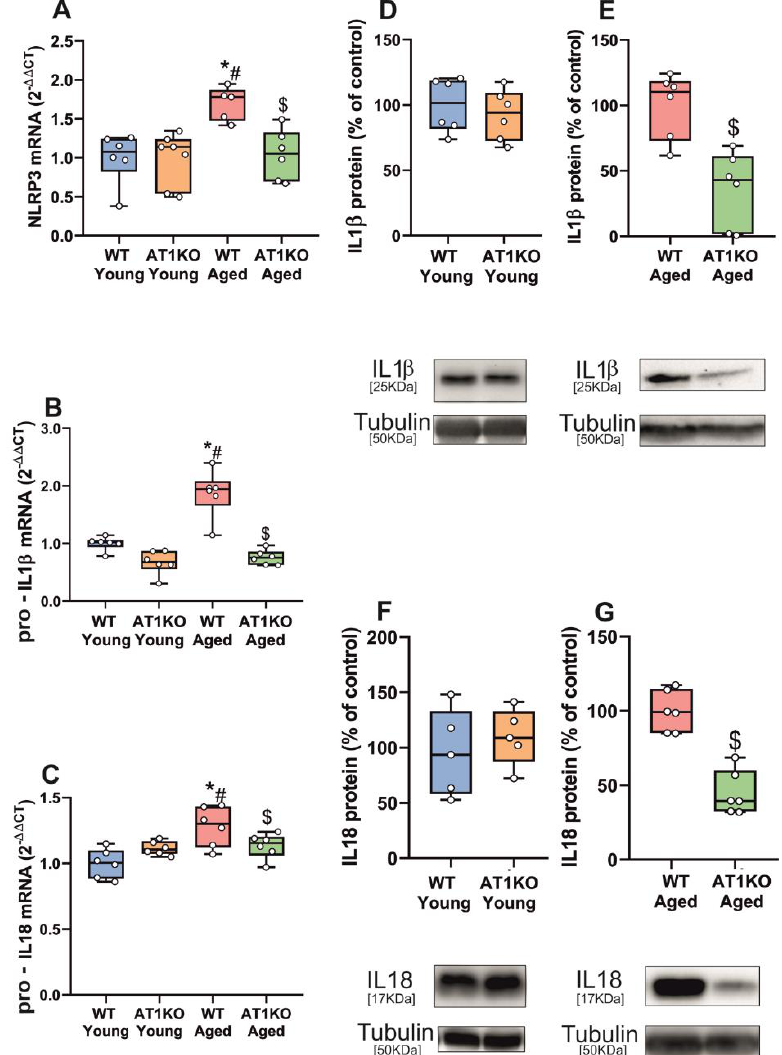
Figure 2. qRT-PCR and WB analysis of NLRP3 inflammasome markers in substantia nigra of WT and AT1 KO mice. mRNA expression of NLRP3, pro- IL1β and pro -IL18 inflammasome markers of aged WT mice significantly increased relative to young WT mice ( A – C ). mRNA inflammasome markers significantly decreased in aged AT1 KO mice vs. aged WT mice ( A – C ). Protein expression of IL1β and IL18 did not show differences in young AT1 KO mice vs. young WT mice ( D , F ) and significantly decreased in aged ATI KO mice vs. aged WT mice ( E , G ). To determine the relative mRNA expres- sion of each gene of interest vs. the β -Actin housekeeping transcripts, we used the comparative Ct values method (2 −ΔΔCt ). Protein expression was determined relative to the α -tubulin band value and normalized to the control values (100%). Data distribution is shown using box plots with boxes rep- resenting the Interquartile range (IQR) and the median and whiskers representing the maximum value (upper whisker) and the minimum (lower whisker). * p < 0.05 relative to young WT mice; # p < 0.05 relative to young AT1 KO mice, $ p < 0.05 relative to aged WT mice.